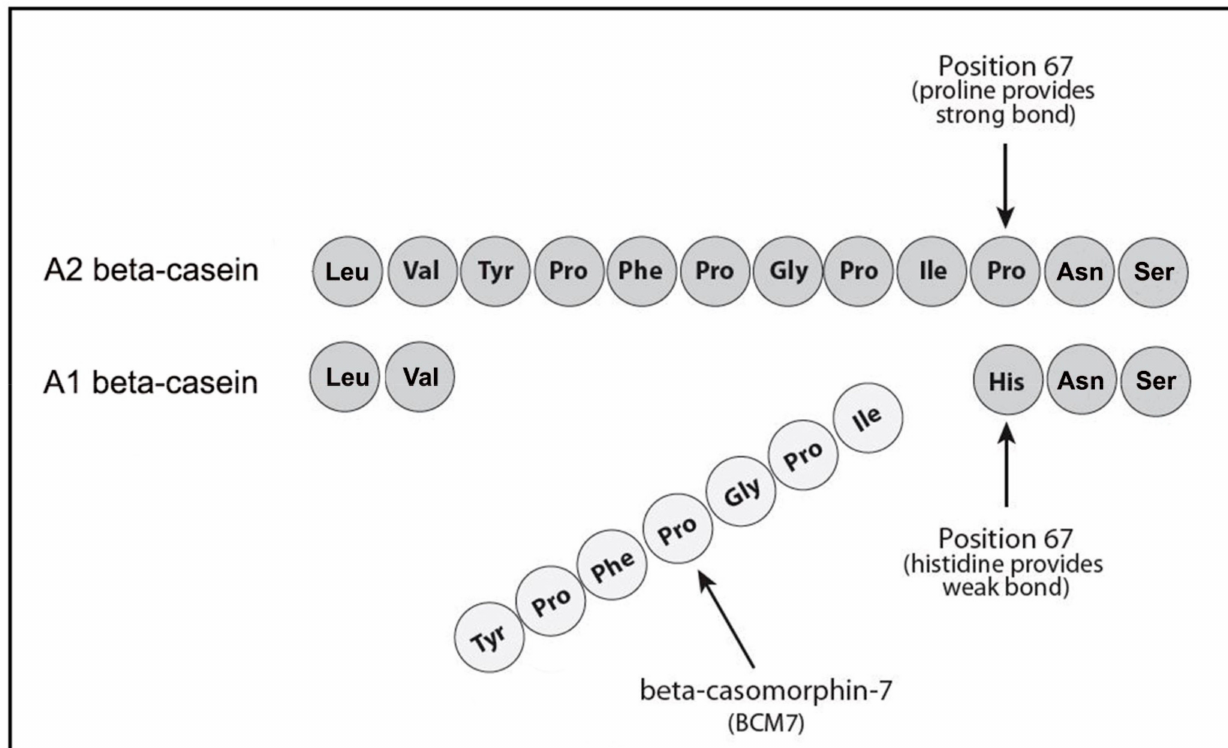
Figure 1. Preferential release of bovine beta-casomorphin-7 from A1